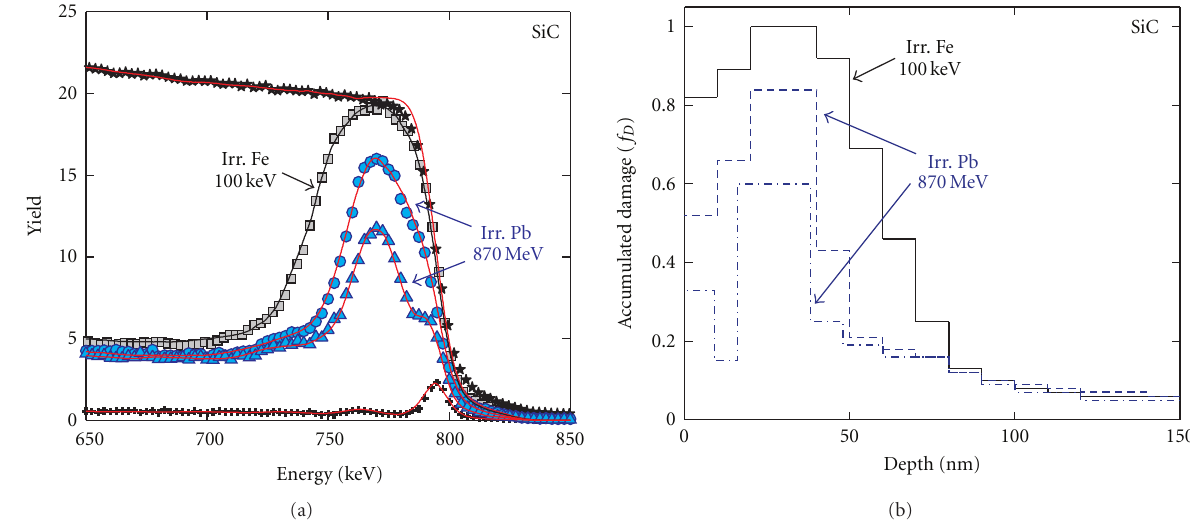
Figure 11: (a) RBS spectra recorded on silicon carbide crystals irradiated at RT with 100-KeV Fe ions (grey squares) and subsequently irradiated at RT with 870-MeV Pb ions (blue symbols) at 7 . 5 × 10 12 cm − 2 (circles) and 2 × 10 13 cm − 2 (triangles). Energy of analyzing He beam: 1.4 MeV. Solid lines are fits to experimental data with the McChasy code [21, 22]. (b) Accumulated damage ( f D ) as a function of depth extracted from the fits to experimental RBS data for silicon carbide crystals irradiated at RT with 100-KeV Fe ions (black line) and subsequently irradiated at RT with 870-MeV Pb ions (blue lines) at 7 . 5 × 10 12 cm − 2 (dashed line) and 2 × 10 13 cm − 2 (dash-dotted